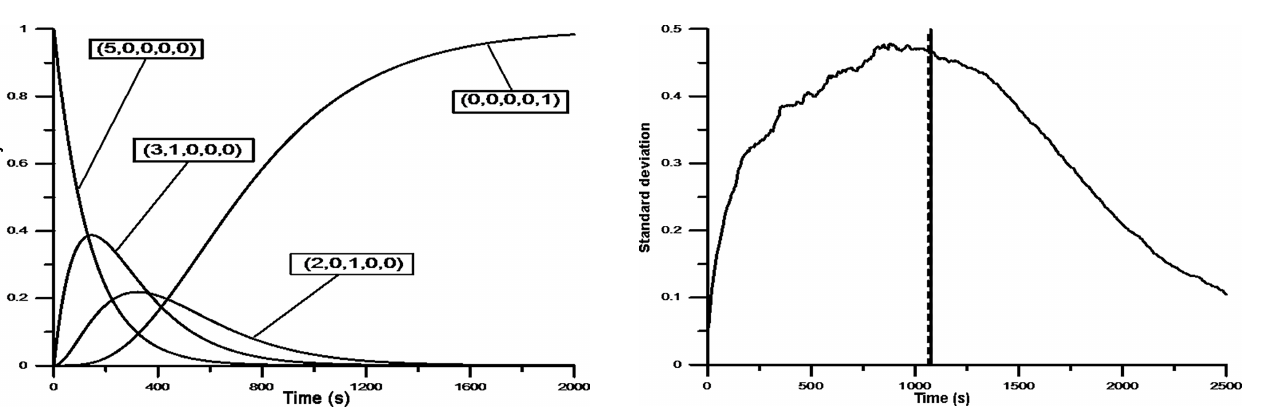
Figure 3. For the finite system, the relative standard deviation σ(S max ) of the largest droplet mass versus time. The initial num- ber of droplets was set equal to N = 40 droplets of 17µm in radius in a volume of 1cm 3 . Simulations were performed with the product kernel K(i,j) = Cx i x j (with C = 5 . 49 × 10 10 cm 3 g − 2 s − 1 ) , and N r = 2000 realizations of the stochastic algorithm were performed. The maximum value of σ(S max ) is found to be 1065s. (dashed ver- tical line) and is very close to the sol gel transition time (continuous vertical line) for the infinite system